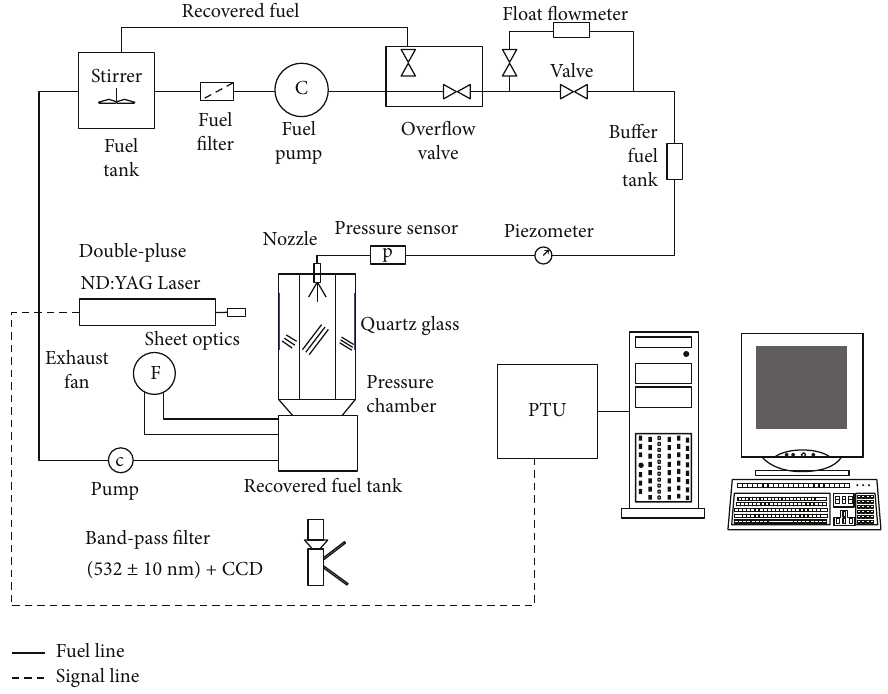
Figure 2: Schematics of the PIV